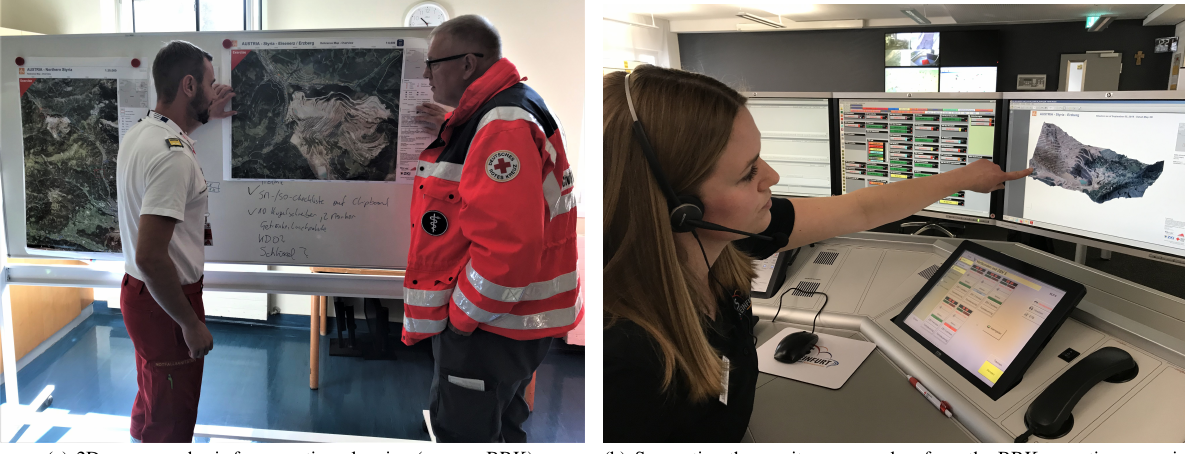
Figure 7. Deployment of map products by the BRK during the IRONORE2019